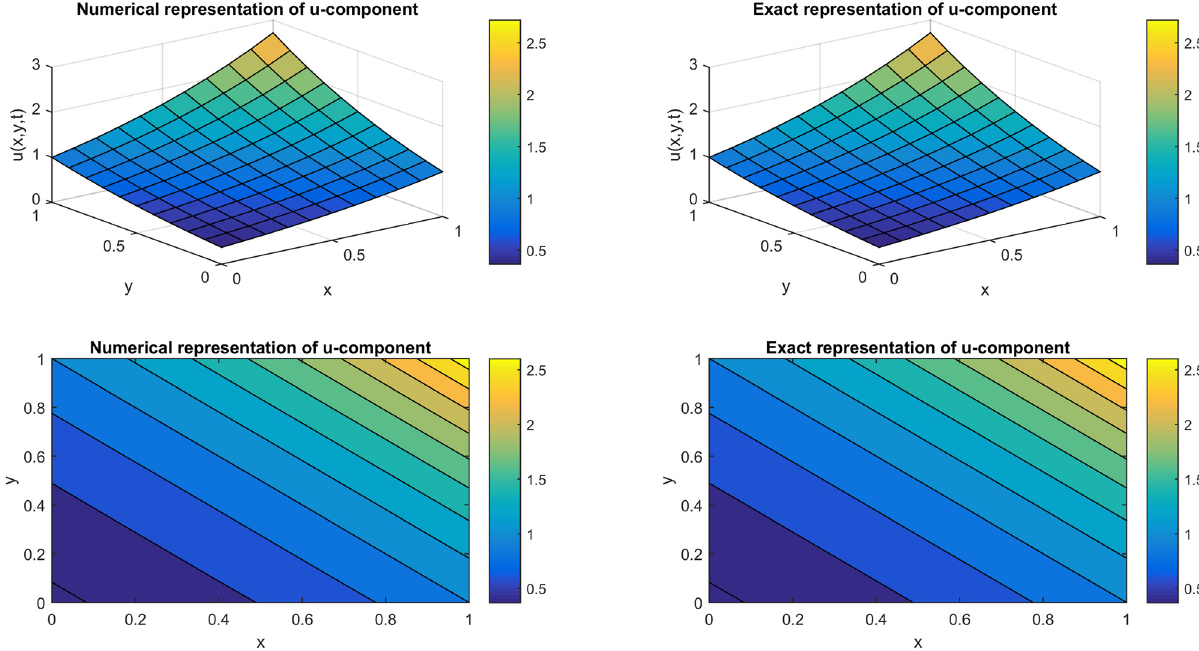
Figure 15: Surface and contour plots for u component at = t 1 for = N 11 , = α 1 , = β 1 , = t Δ 0.0001 , and = τ 0.5 using Method I regarding Example 8.